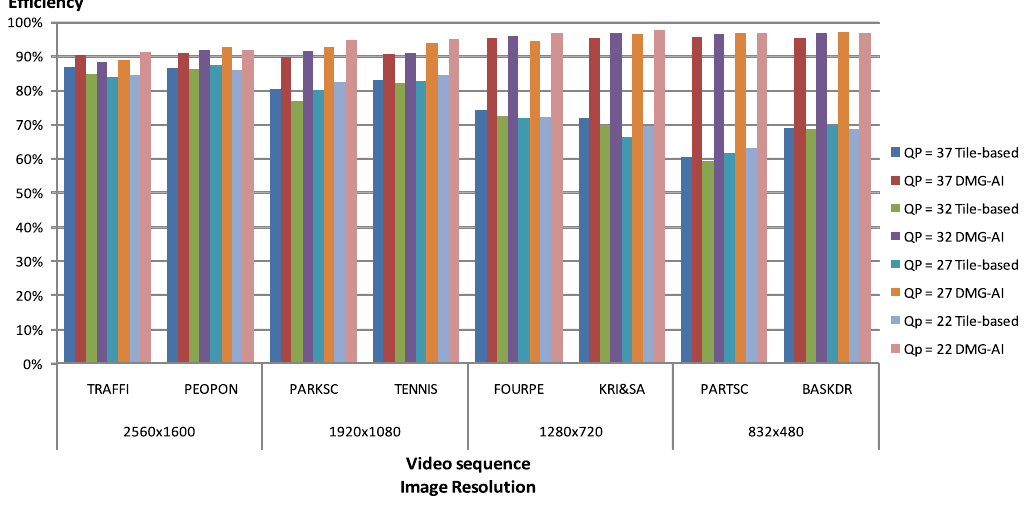
Figure 12. Tile-based vs. DMG-AI parallel